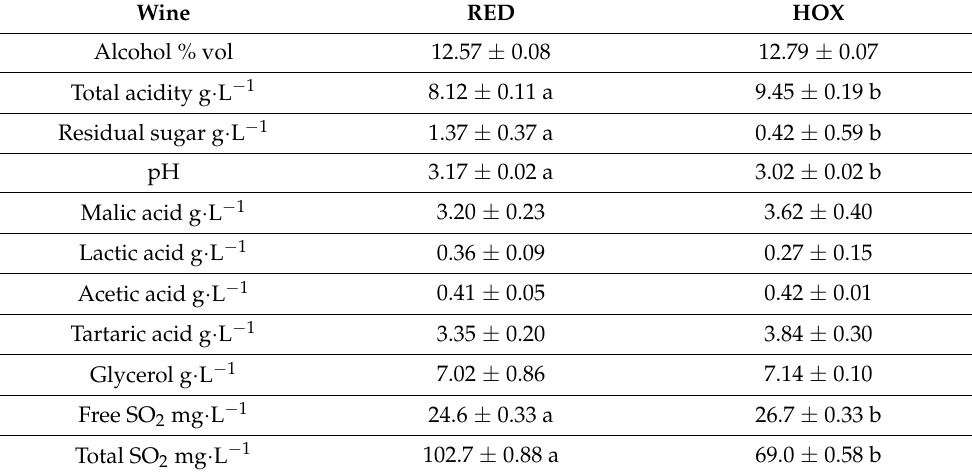
Table 1. Basic analytical parameters of final wines.